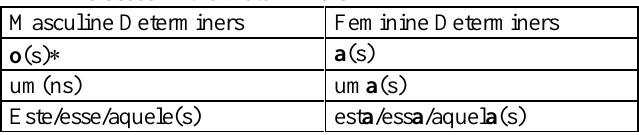
Table 1. Morphological pattern of the Portuguese